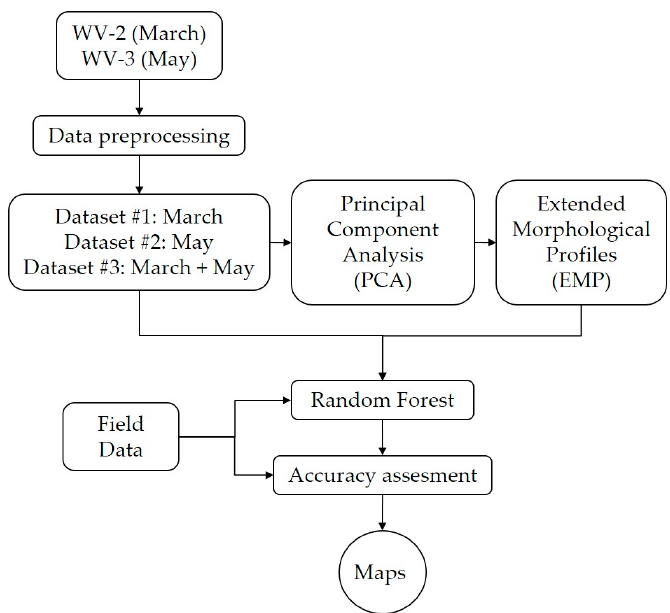
Figure 3. The methodology framework of the study.